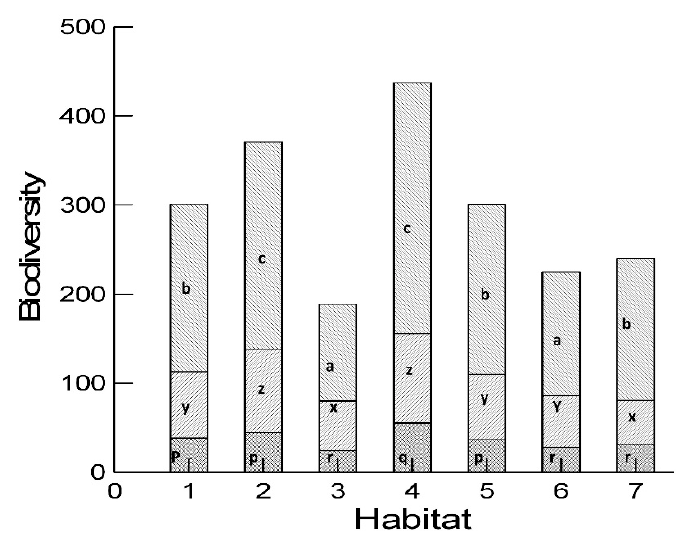
types. Three triplets were used for the segments, namely [a,b,c], [x,y,z], and [p,q,r].